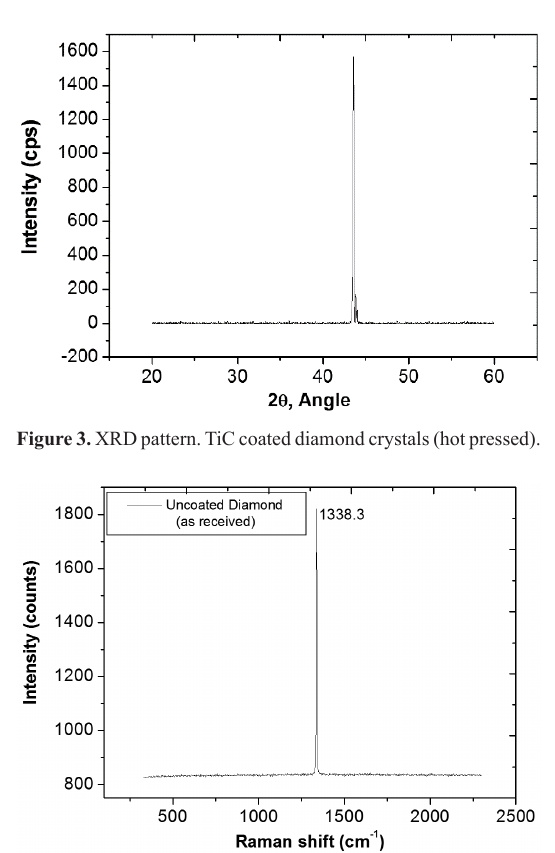
Figure 6. Raman spectroscopy of TiC coated diamond, after hot pressing and chemical